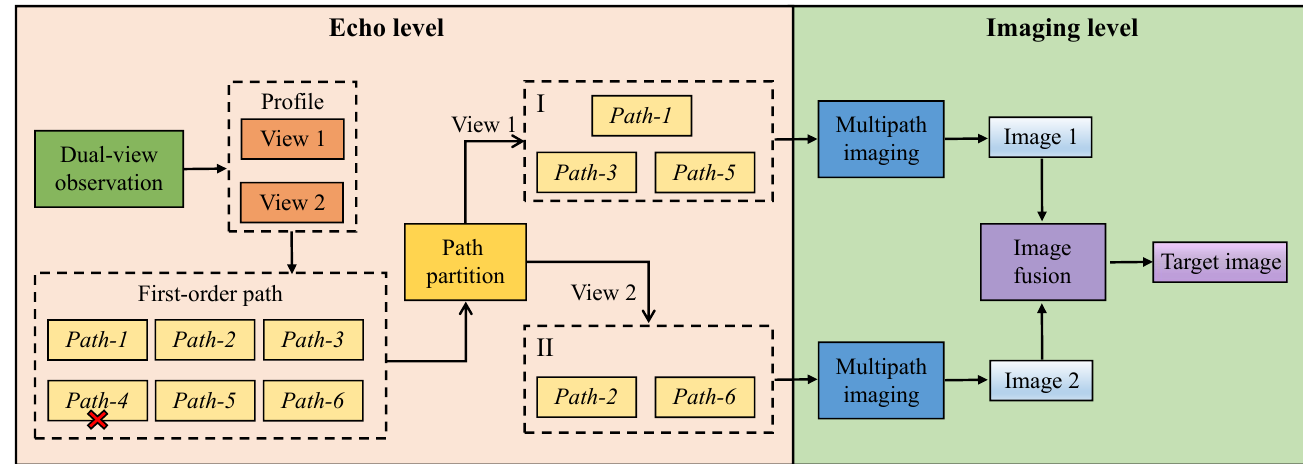
Figure 6. Flowchart of dual-view observation method.